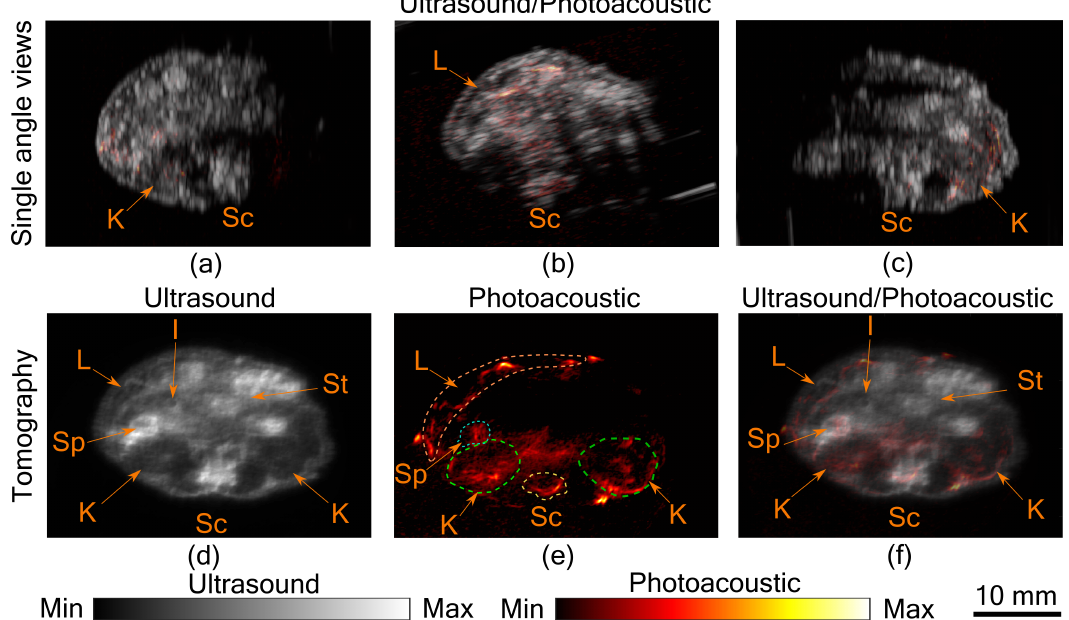
Figure 2. Tomographic photoacoustic and ultrasound imaging. ( a – c ) Co-registered ultrasound and photoacoustic B-Scan images of mouse abdomen, acquired from three different angles. Tomographic ( d ) ultrasound, ( e ) photoacoustic, and ( f ) co-registered ultrasound and photoacoustic image. Several organs in the abdominal region indicated by Sc-spinal cord, K-kidney, L-liver, Sp -spleen, St-stomach, and I-intestine. Dashed lines are used to mark the organs in the photoacoustic